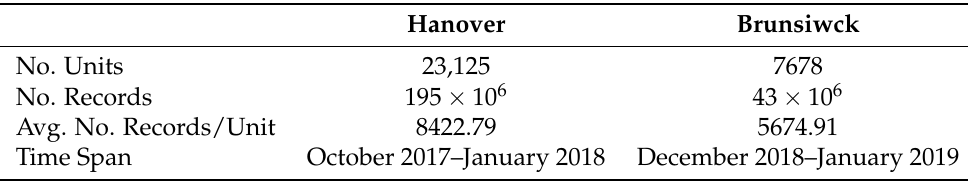
Table 1. Dataset statistics for Hanover and